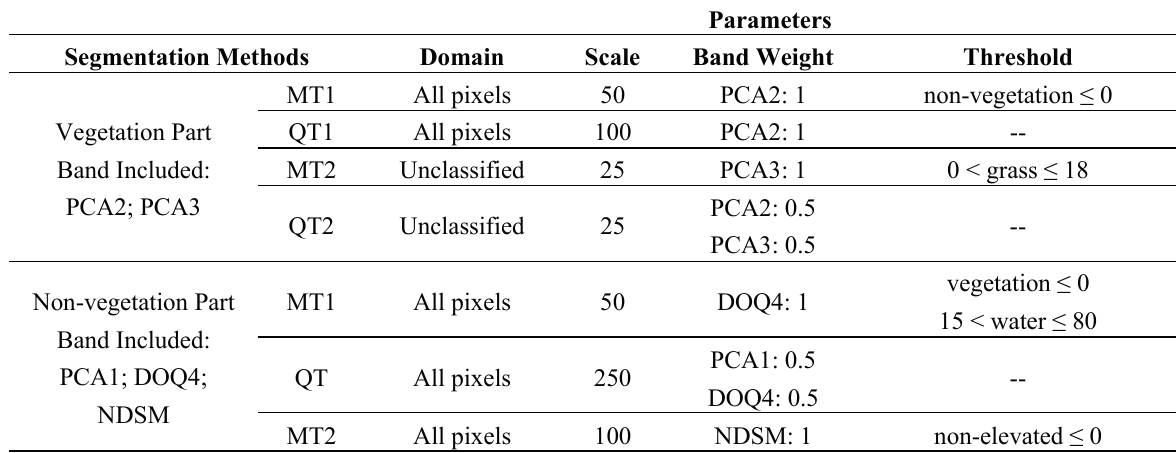
Table 1. Segmentation methods and parameter settings used in the object-based classification procedures.